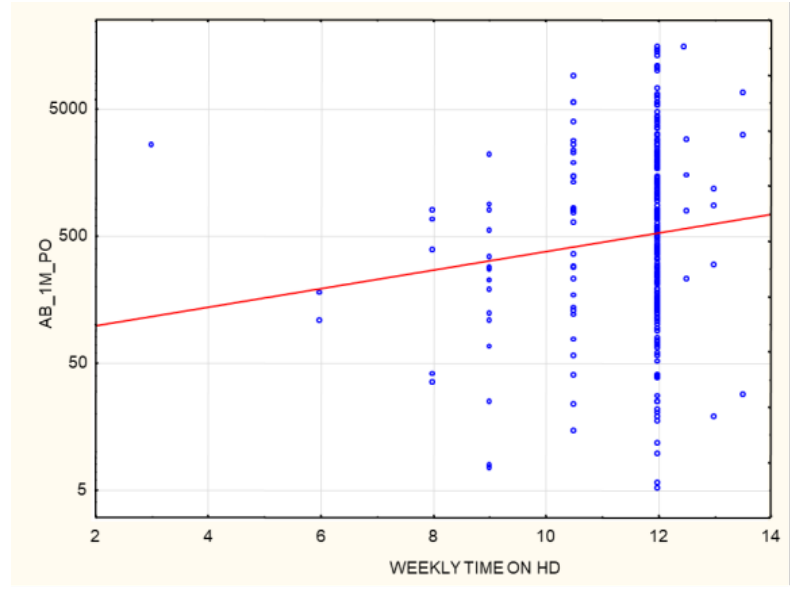
Figure 16. Positive correlation between AB levels (AU/mL) at 1 month after the 2nd dose of SARS- CoV-2 vaccine and the weekly time (hours) on HD ( p = 0.017, R 0.14). Spearman’s rank correlation test. AB: antibody, HD: hemodialysis. A negative correlation was found between post-vaccination AB levels and absolute neutrophil count ( p = 0.03, R − 0.13). The correlation is statistically significant, although the strength of the relationship between the examined factors was weak (Figure